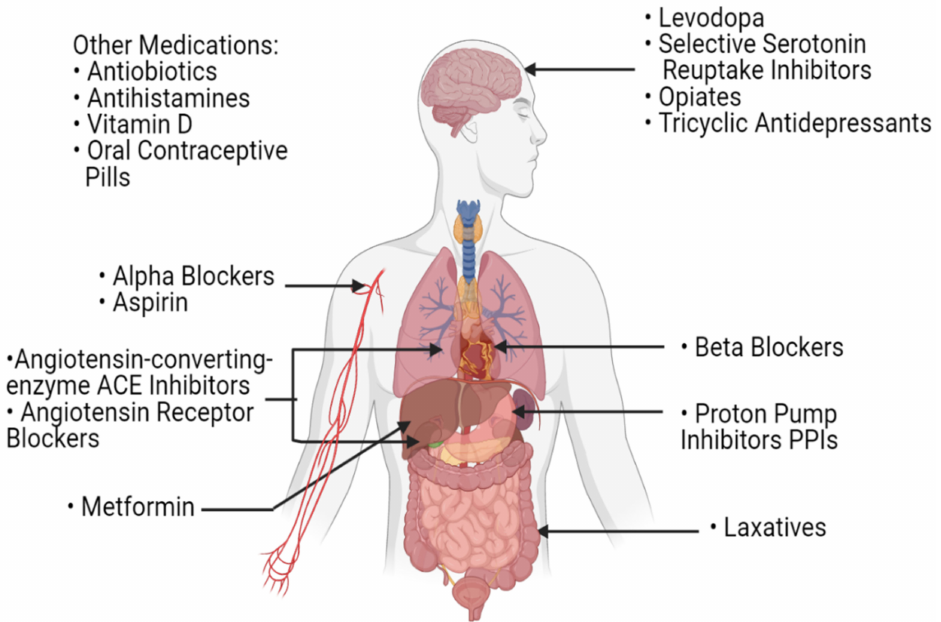
Figure 4. A list of commonly used medications in the daily routine of patients with cancer. These medications can influence the gut microbiota and potentially affect the host’s response to immune checkpoint